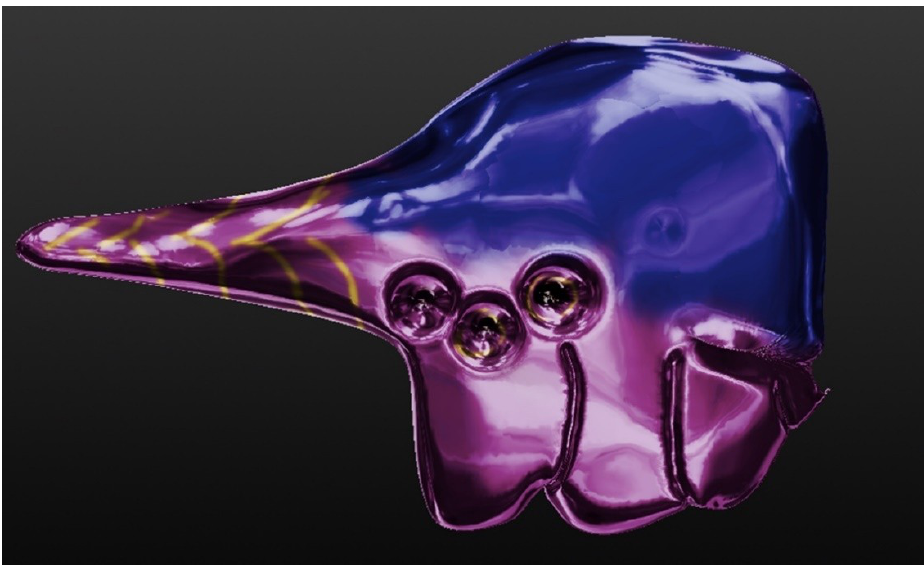
Figure 24. Shenzianyuloma yunnanense nov. gen. nov. sp., digital reconstruction. This partial reconstruction omits the dorsal fin and any conjectural tail/caudal ‘fin,’ as the posterior tip of the animal is unknown. Image Credit: Mark McMenamin, using Sculptris Alpha 6 by Pixologic, Inc. Vetulicolian